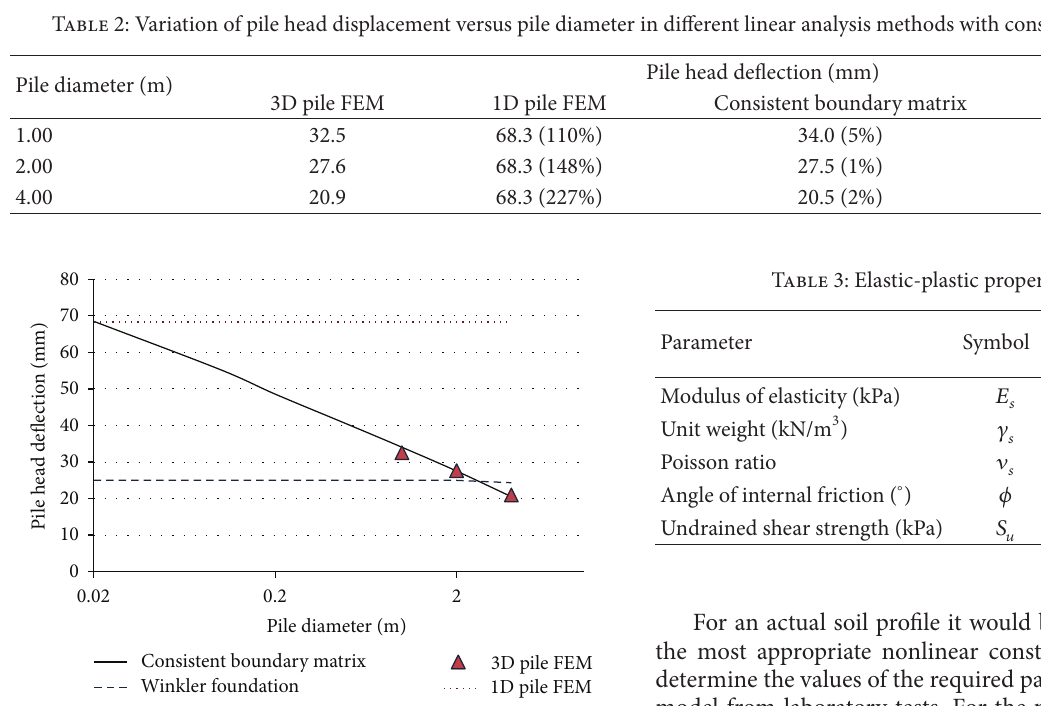
F 4: Variation of pile head displacement versus pile diameter in linear analyses with constant EI for the pile.